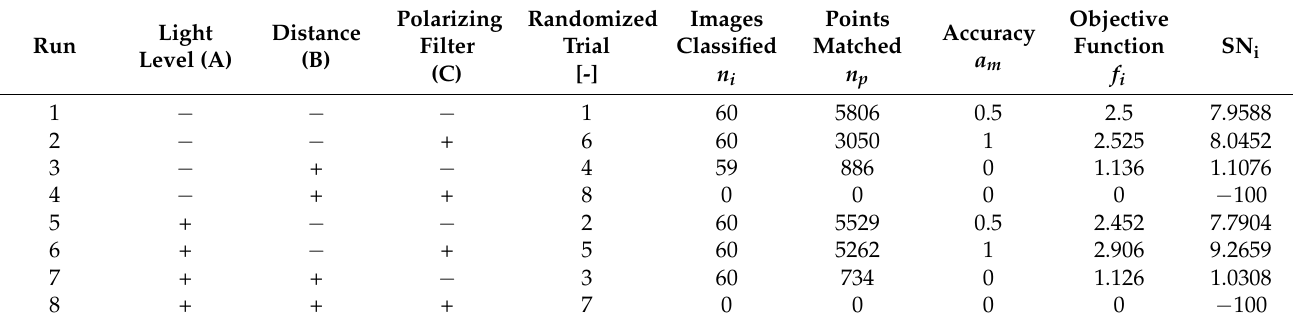
Table 4. Parametric optimization results.